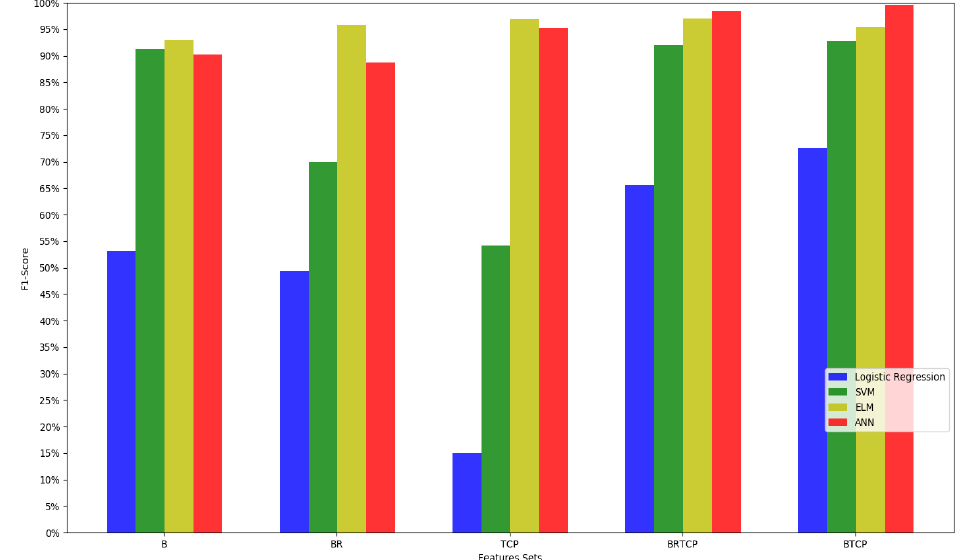
Figure 7. The F1-Score by feature sets and